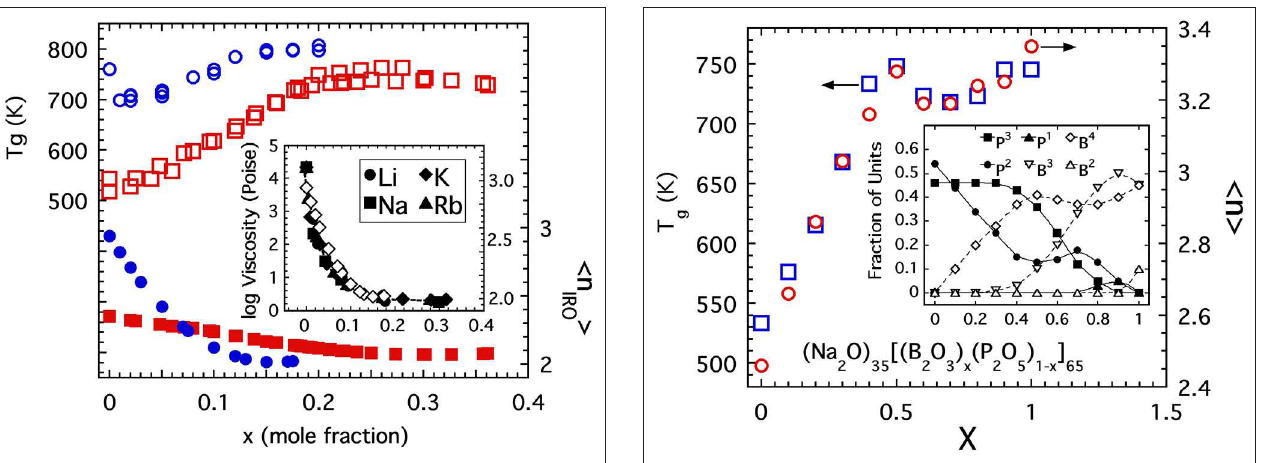
FIGURE 13 | The glass transition temperature (open squares, scale on left side) and average bridging oxygen per network forming cation (open circles, scale on right side) of sodium borophosphate glasses (Christensen et al., 2012 ). Inset shows the fraction of boron and phosphate units with a given bridging oxygen coordination number used in computing h n i